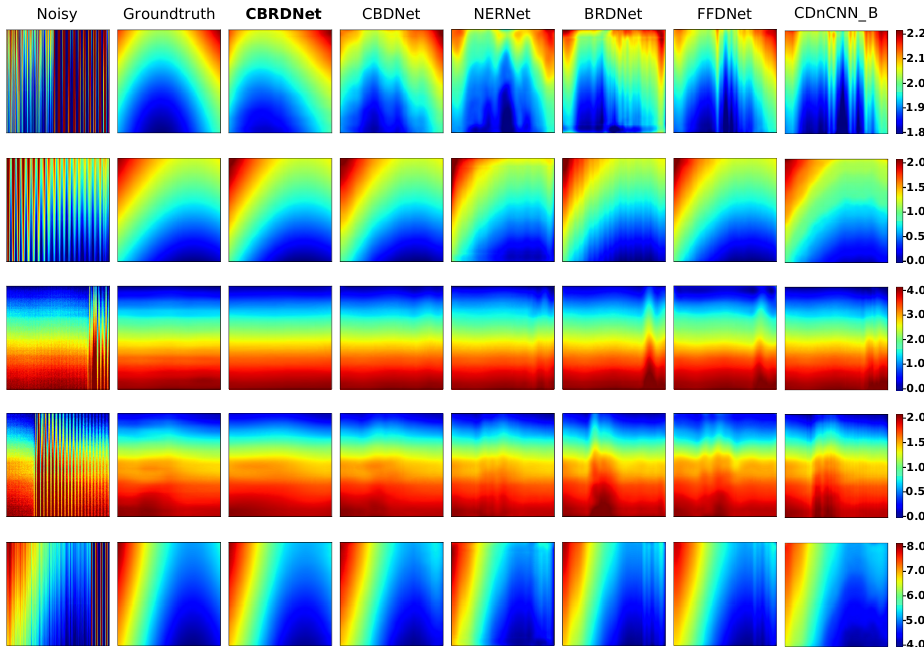
Figure 11. Comparison of our proposed CBRDNet with other methods on five different samples. Note that because of the low SNR, the geometrical surface of the samples is hidden by the induced perturbations. To facilitate the comparison with the denoised samples, the color scale of the images corresponding to the first column, i.e., noisy sample, is clipped. Color scale values are expressed in millimeters (mm). (Color